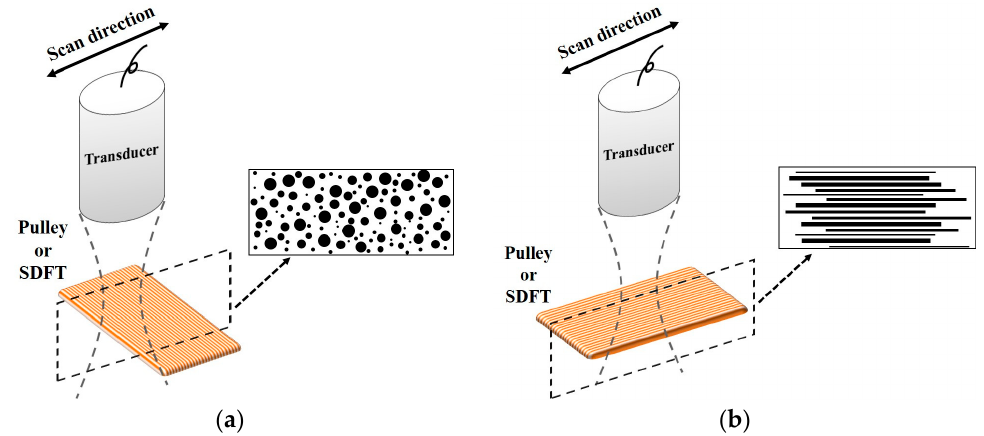
Figure 9. Diagrams of the scatterer distribution in the A1 pulley and SDFT as the ultrasonic transducer imaged ( a ) across the fiber axis and ( b ) along the fiber axis.